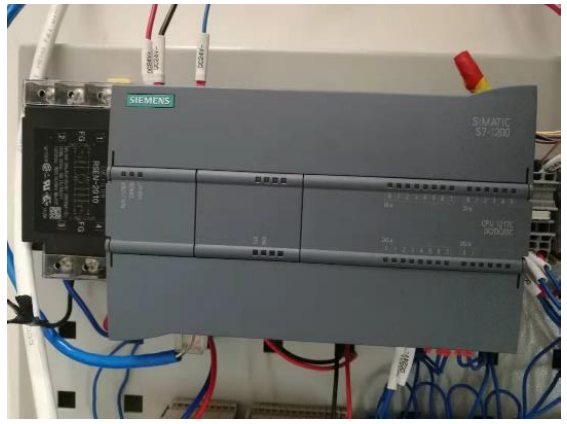
Figure 13. Programmable Logic Controller (PLC) physical diagram of S7-1200.